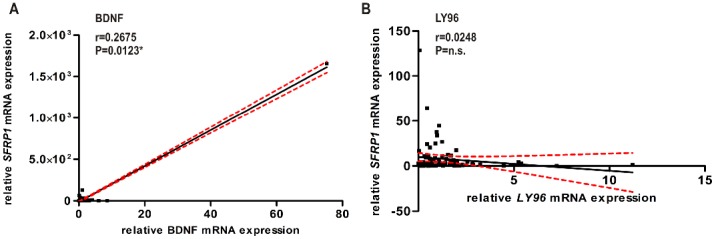
Correlation analysis of mRNA expression in human breast cancer tissues.(A) By comparing the BDNF and SFRP1 mRNA expression of 87 tumor samples a significant correlation was found (Spearman coefficient, p<0.05). (B) A correlation between LY96 and SFRP1 mRNA expression in 86 human breast cancer tissues could not be detected. n.s.: not significant.